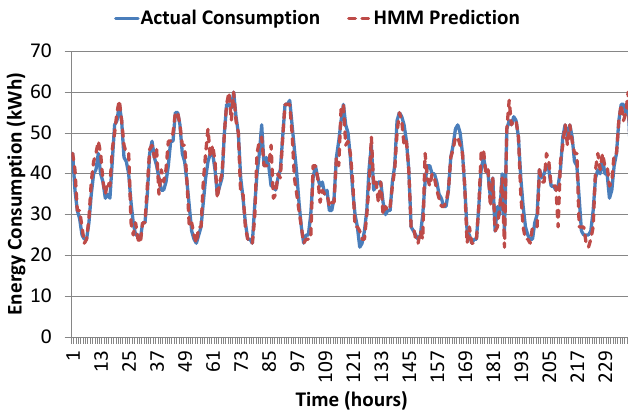
Figure 10. Proposed model prediction results in comparison with actual consumption for 10 days hourly data.